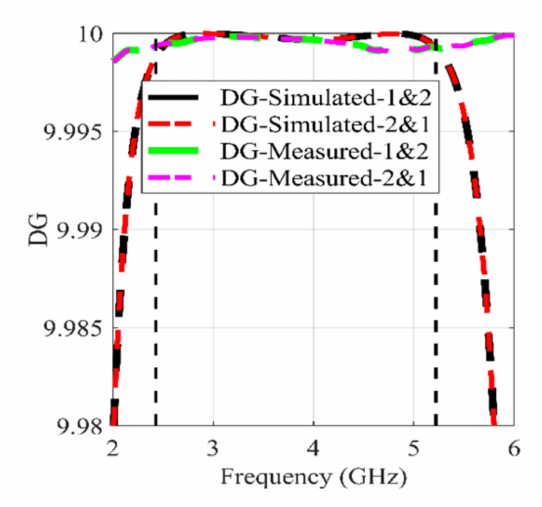
Figure 18. The measured and simulated DG for mid-band MIMO configuration.